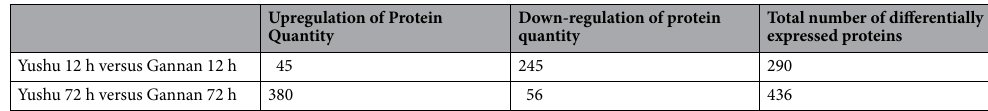
Table 2. Numbers of Differentially Expressed Proteins (quantitative ratio > 1.2 or < 0.833, P < 0.05).